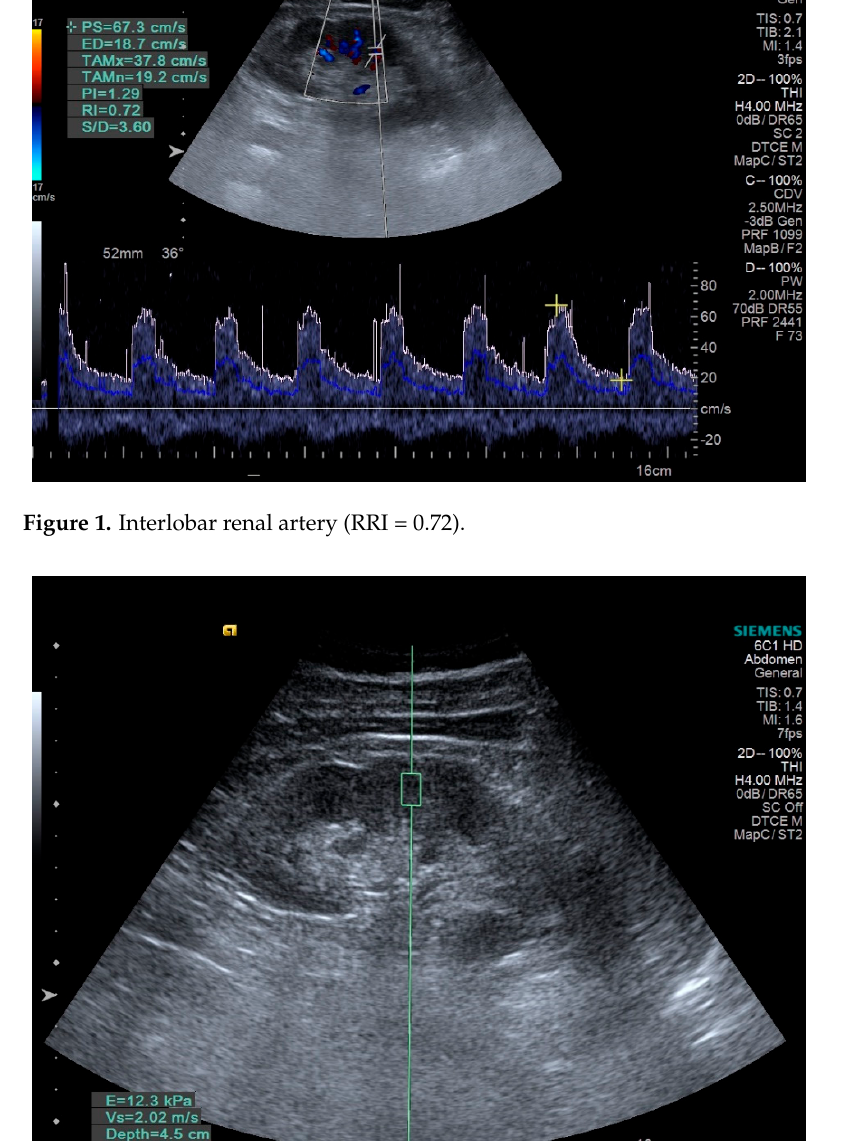
Table 3. Monitorized parameters in HN patients depending on the severity of hypertension.